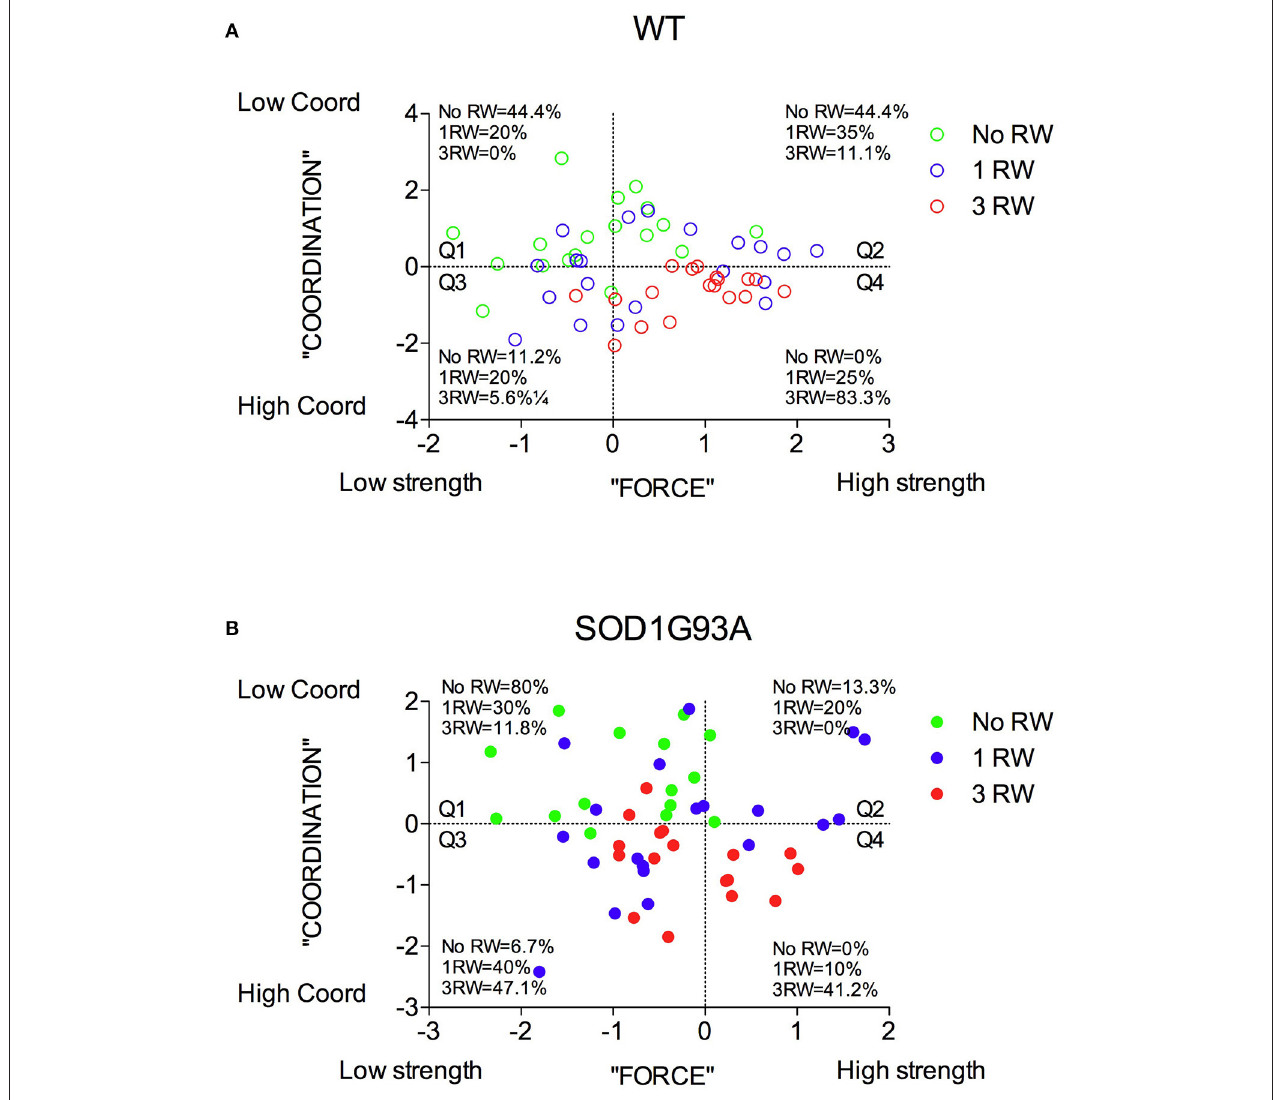
FIGURE 8 | Distribution of mice from the three exercise groups in the PC1 “Force” and PC2 “Coordination” principal components space. (A) Wild-type and (B) SOD1G93A mice distribution and percentage of individuals of the three exercise groups in the four quadrants subdividing the “Force”/“Coordination”